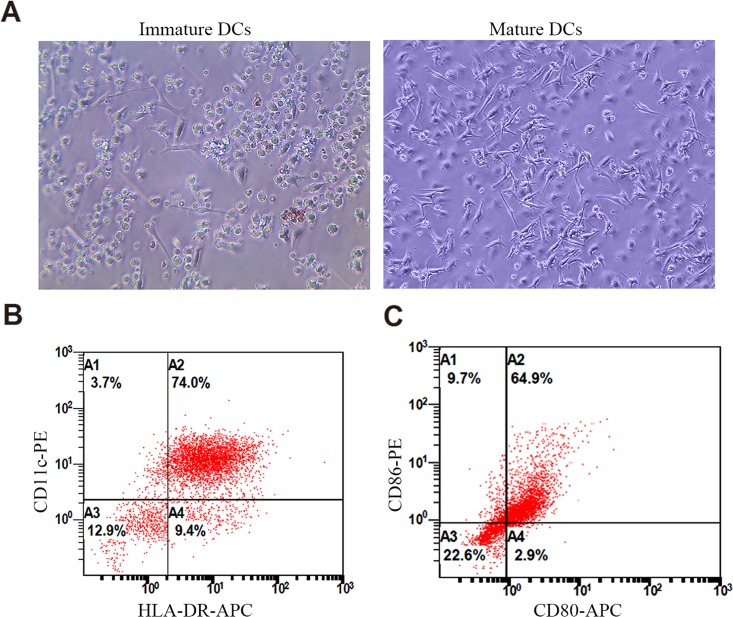
Identification of human DCs.(A) Examples of immature and mature DCs. Immature DCs showed multiple spiculated edges. Mature DCs were veiled or dendritic spine-like at semi-suspension state; (B) Flow cytometry identification of mature DCs: the ratios of CD11c-, HLA-DR-, CD86-, and CD80-positive cells to total cells were 77.7%, 83.4%, 74.9% and 67.8%, respectively.